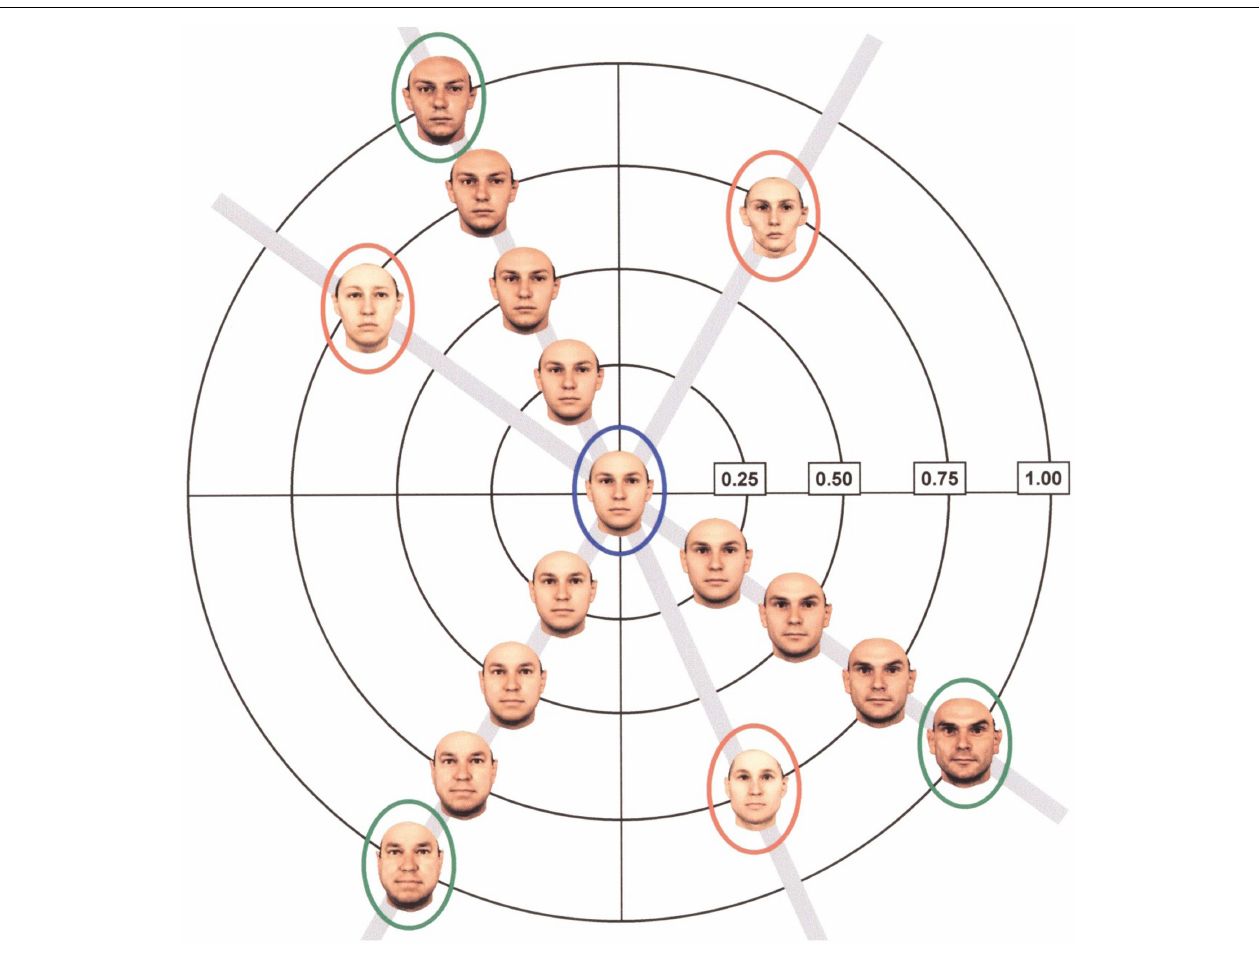
average face (blue ellipse) by an “identity trajectory.” Numbers refer to the “identity strength” possessed by the given face (taken from Leopold et al.,